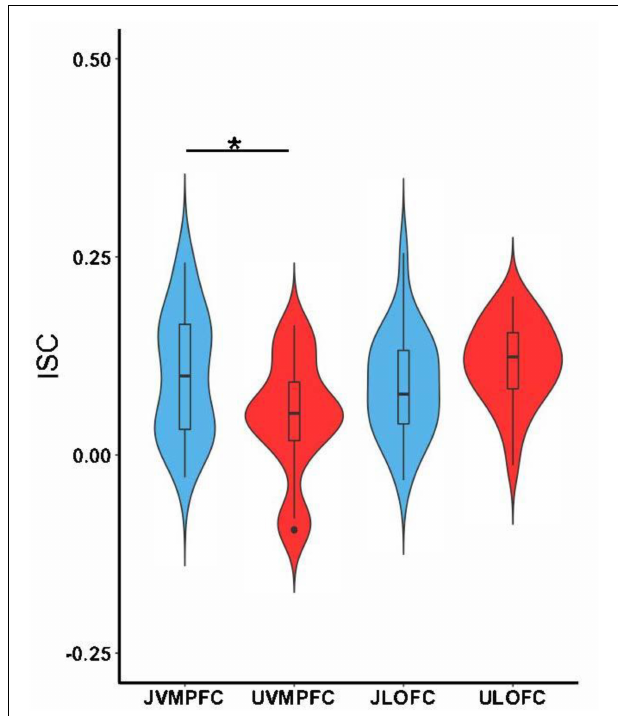
FIGURE 5 | Tests of differences collapsing over character and action segments. The boxplots show the mean and the standard deviation. The ISC in the vmPFC was significantly higher while participants watched justified movie violence (JvmPFC) compared to when participants watched unjustified movie violence (UvmPFC). There was no significant difference between ISC in lOFC for justified (JlOFC) versus unjustified (UlOFC) movie violence ( ∗ p <